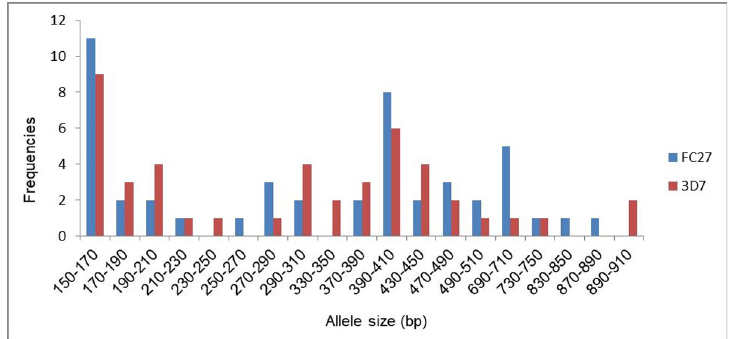
Fig 3. Prevalence of P . falciparum FC27 and 3D7 msp2 alleles classified by length (base